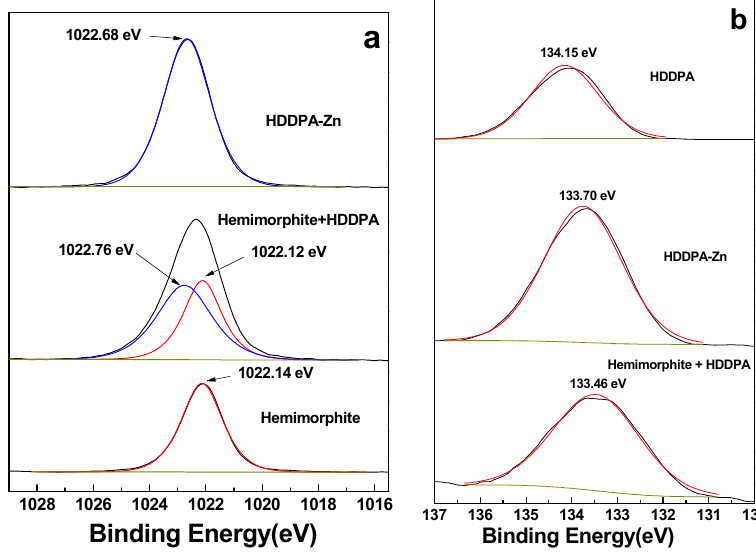
Figure 9. High-resolution XPS of Zn 2p3/2 ( a ) and P 2p ( b ).